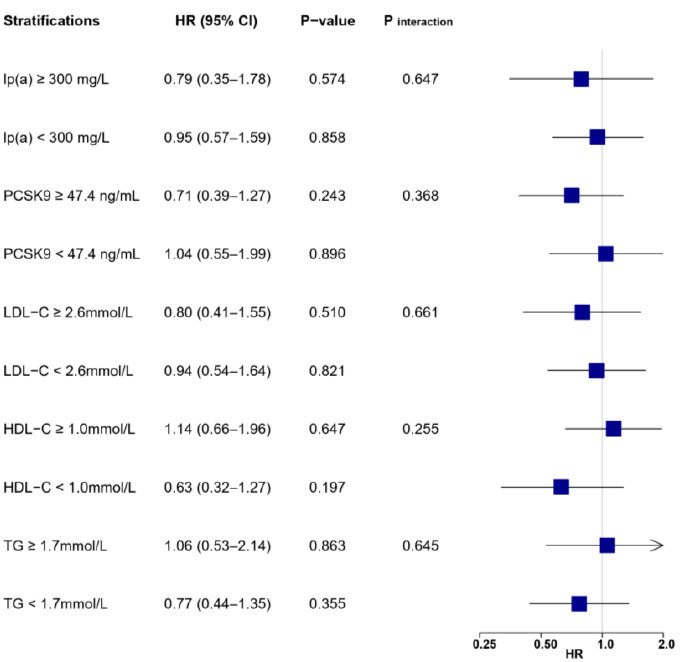
Figure 7. Associations between LL-37 and the risk of cardiac death according to lipid profile values. Multivariable Cox regression was adjusted for variables with p < 0.1 in univariable analysis (see Supplementary Table S4), including age, gender, body mass index, hypertension, diabetes, previous myocardial infarction, heart rate, systolic BP, diastolic BP, ejection fraction, leucocytes, hemoglobin, creatinine, glucose, hemoglobin A1c, high-sensitivity C-reactive protein, cardiac troponin I, N-terminal prohormone of brain natriuretic peptide, LDL-C, lp(a), culprit lesion, multivessel diseases, successful revascularization, P2Y12 inhibitor, and statin. BP = blood pressure; HDL-C = high-density lipoprotein cholesterol; LDL-C = low-density lipoprotein cholesterol; lp(a) = lipoprotein(a); PCSK9 = proprotein convertase subtilisin/kexin type 9; TG = triglyceride.